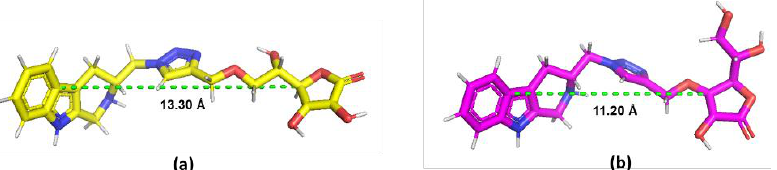
Figure 3. Distance between the aromatic end group and the ascorbic furanone ring in the 3D structure of ascorbic derivatives: ( a ) 2c (yellow) and ( b ) 5c (magenta).